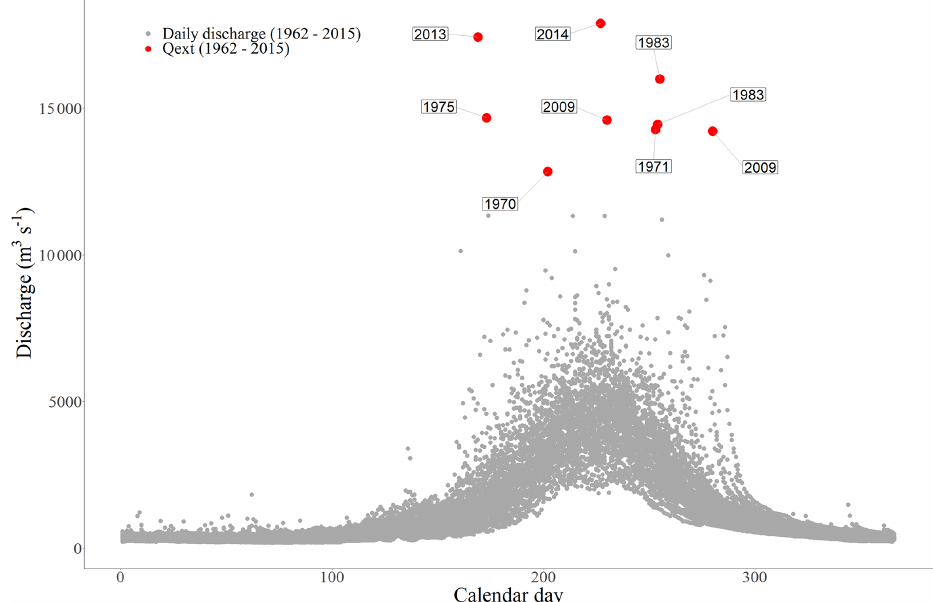
Figure A4. Hydrological year showing the daily discharge measurements and their calendar day. Red dots represent the identified extreme discharges ( Q ext ) that are higher than 12500m 3 s − 1 .